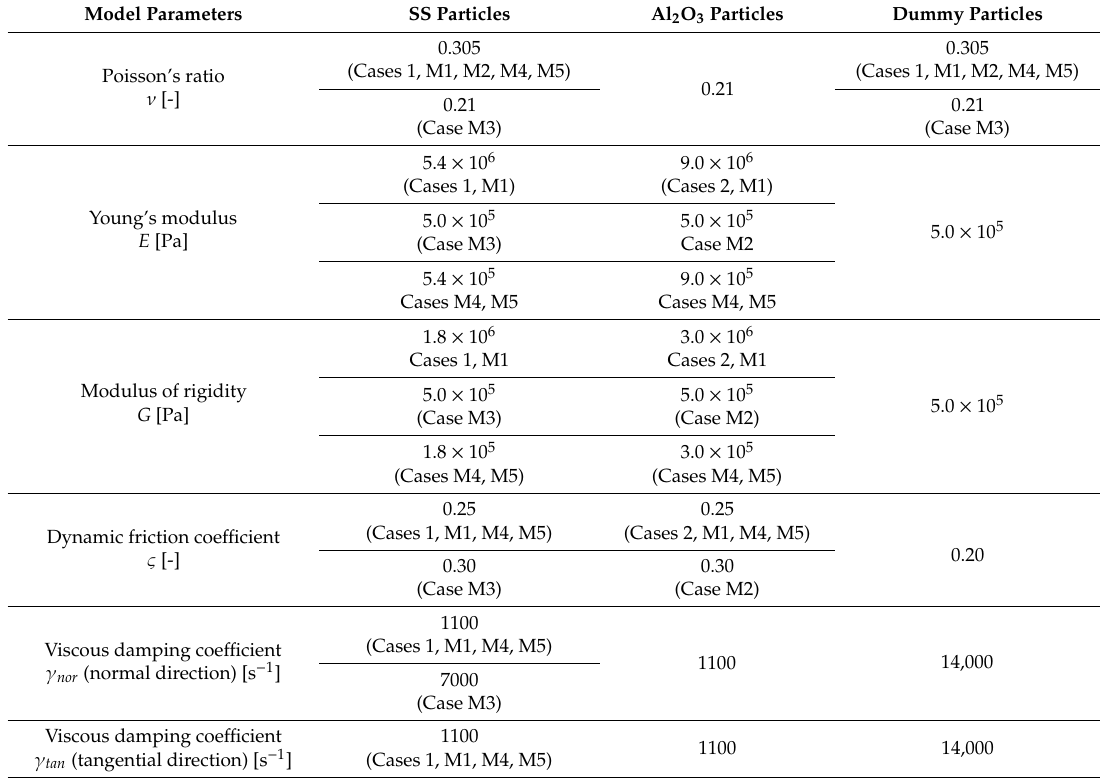
Table 2. Values of model parameters used in the DEM